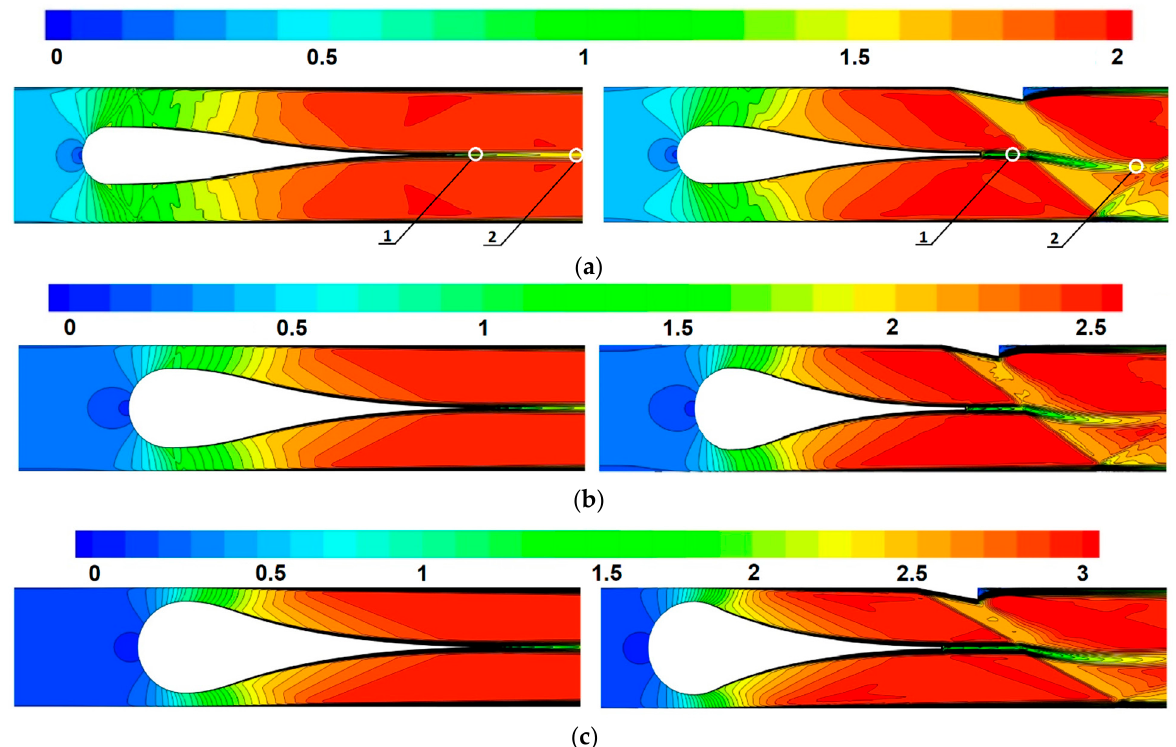
Figure 3. Mach number fields without (left) and with (right) oblique shock wave. ( a ) nozzle 1, ( b ) nozzle 2, ( c ) nozzle 3.